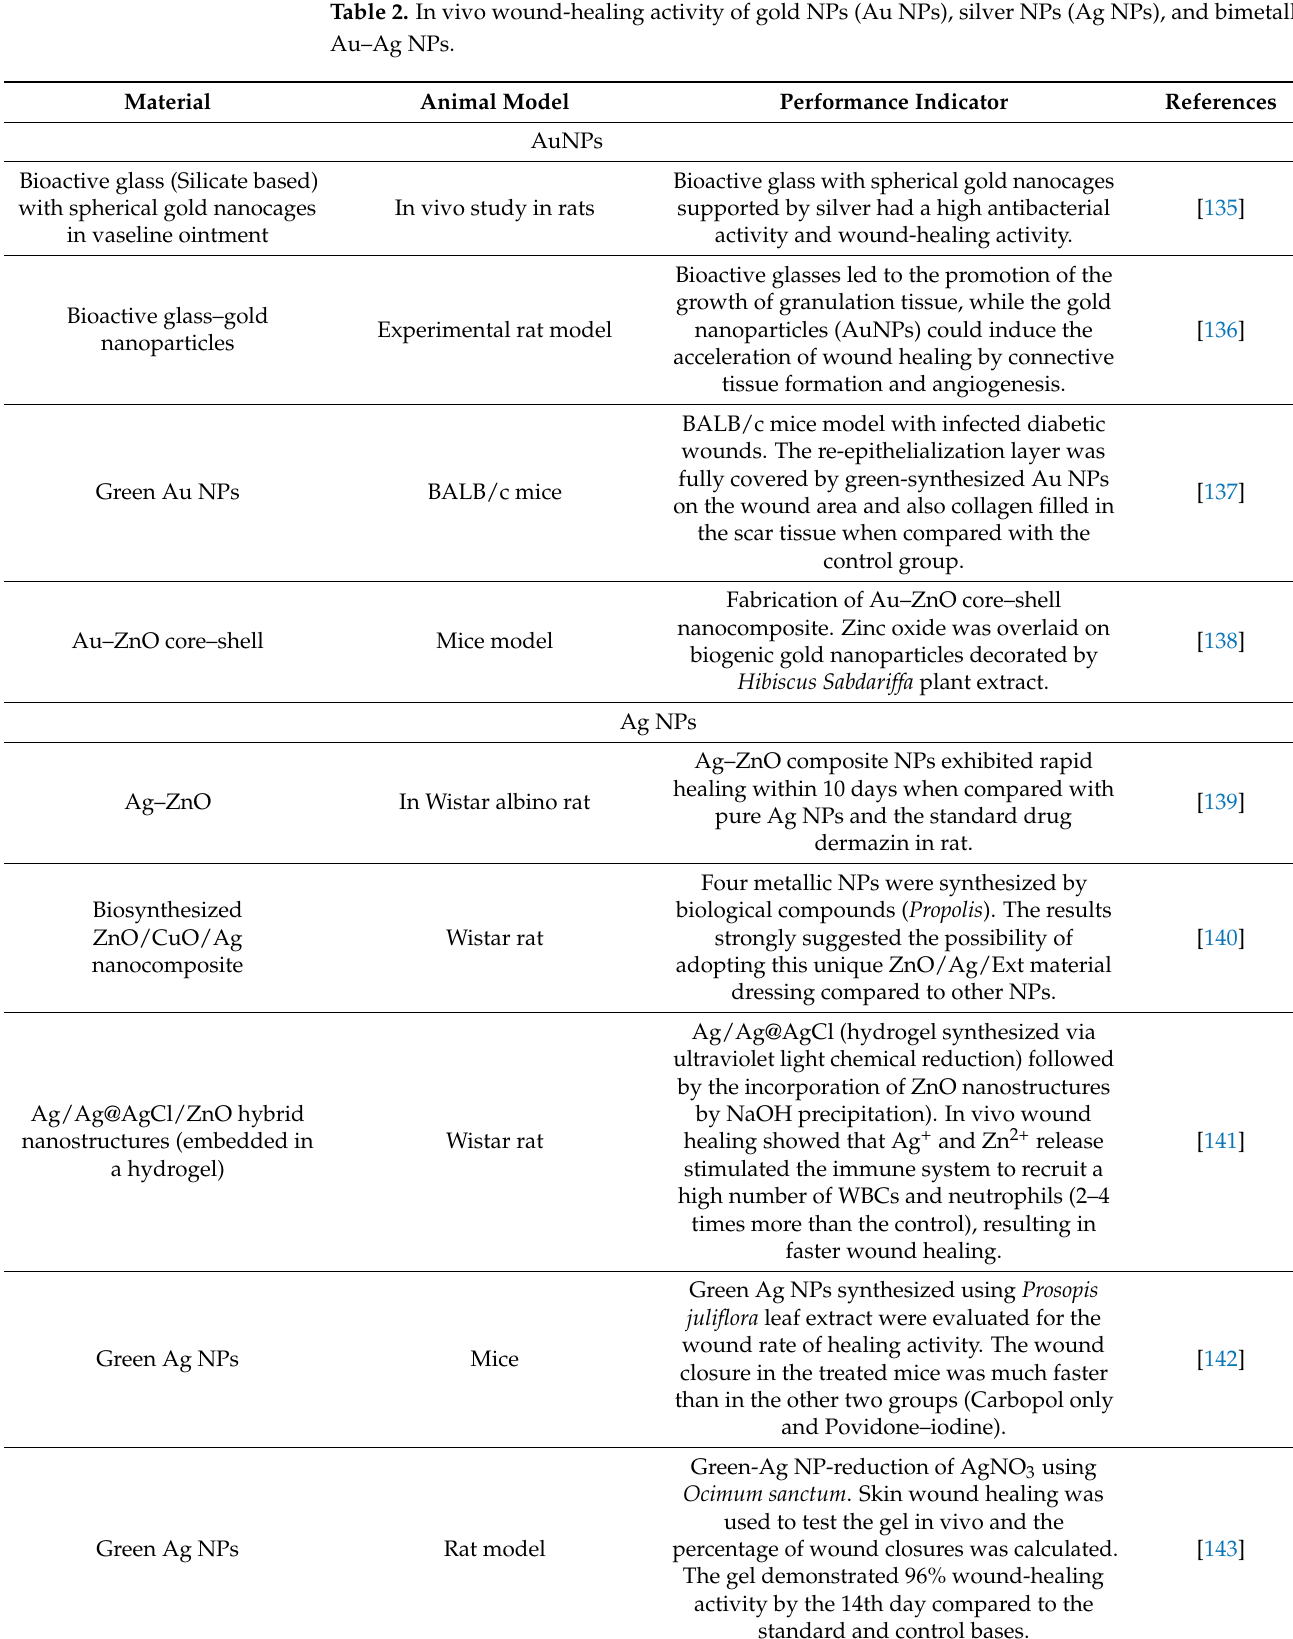
Table 2. In vivo wound-healing activity of gold NPs (Au NPs), silver NPs (Ag NPs), and bimetallic Au–Ag